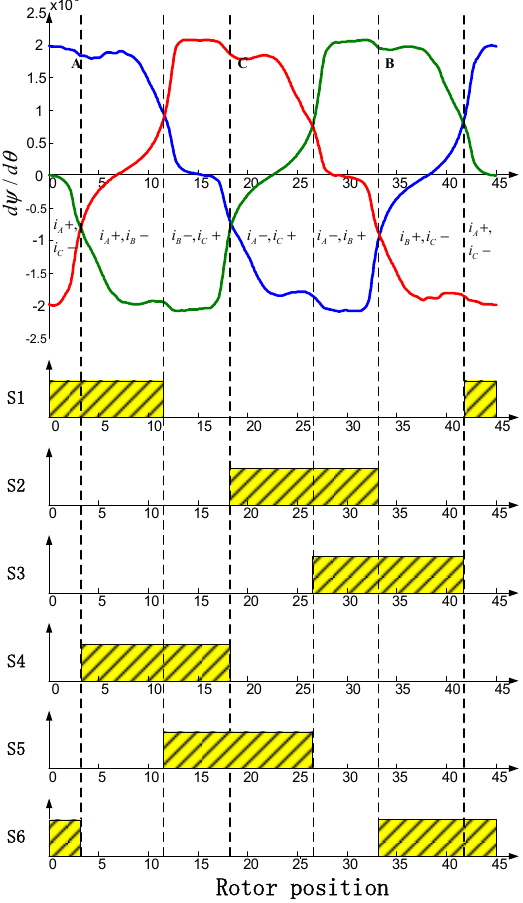
Figure 3. Back electromagnetic force (EMF) waveform.